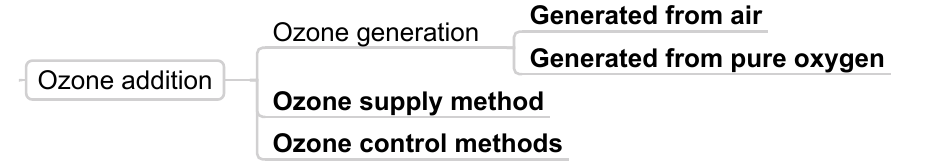
Figure 13. Partial taxonomy: Ozone